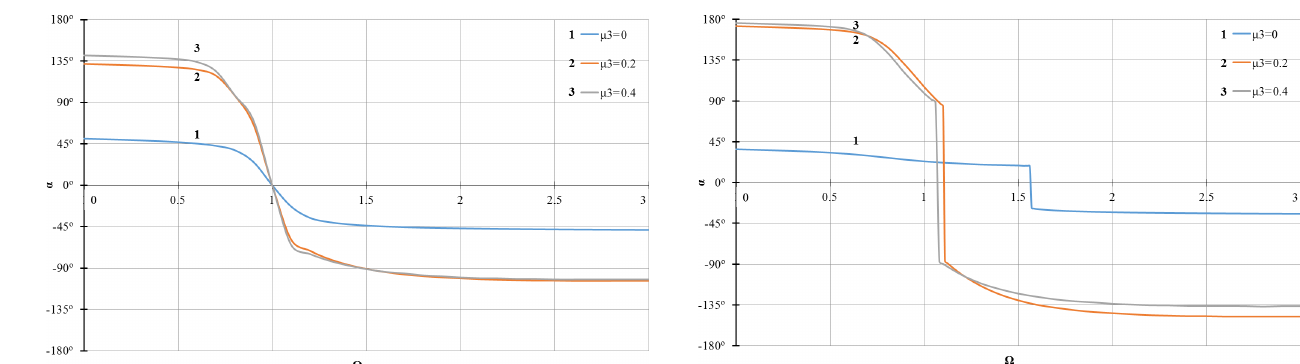
Figure 17. Dependence of the vibration phase α on the rotor speed (cid:127) with coefficient of non-linear stiffness of the support K 3 = 0 . 1 and at value of the coefficient of linear viscous damping µ 1 = 0 . 1 and different values of the nonlinear viscous damping coefficient µ 3 .